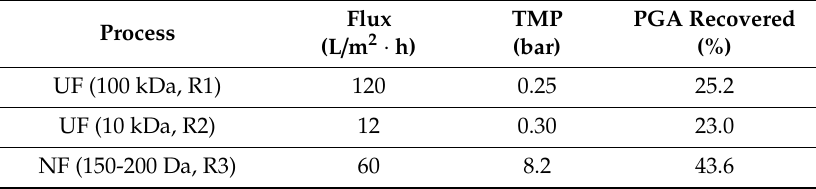
Table 3. Ultrafiltration (UF) and nanofiltration (NF) process parameters and PGA recovered with respect to the undialyzed PGA processed. Flux is the volume permeated over time and TMP is the transmembrane